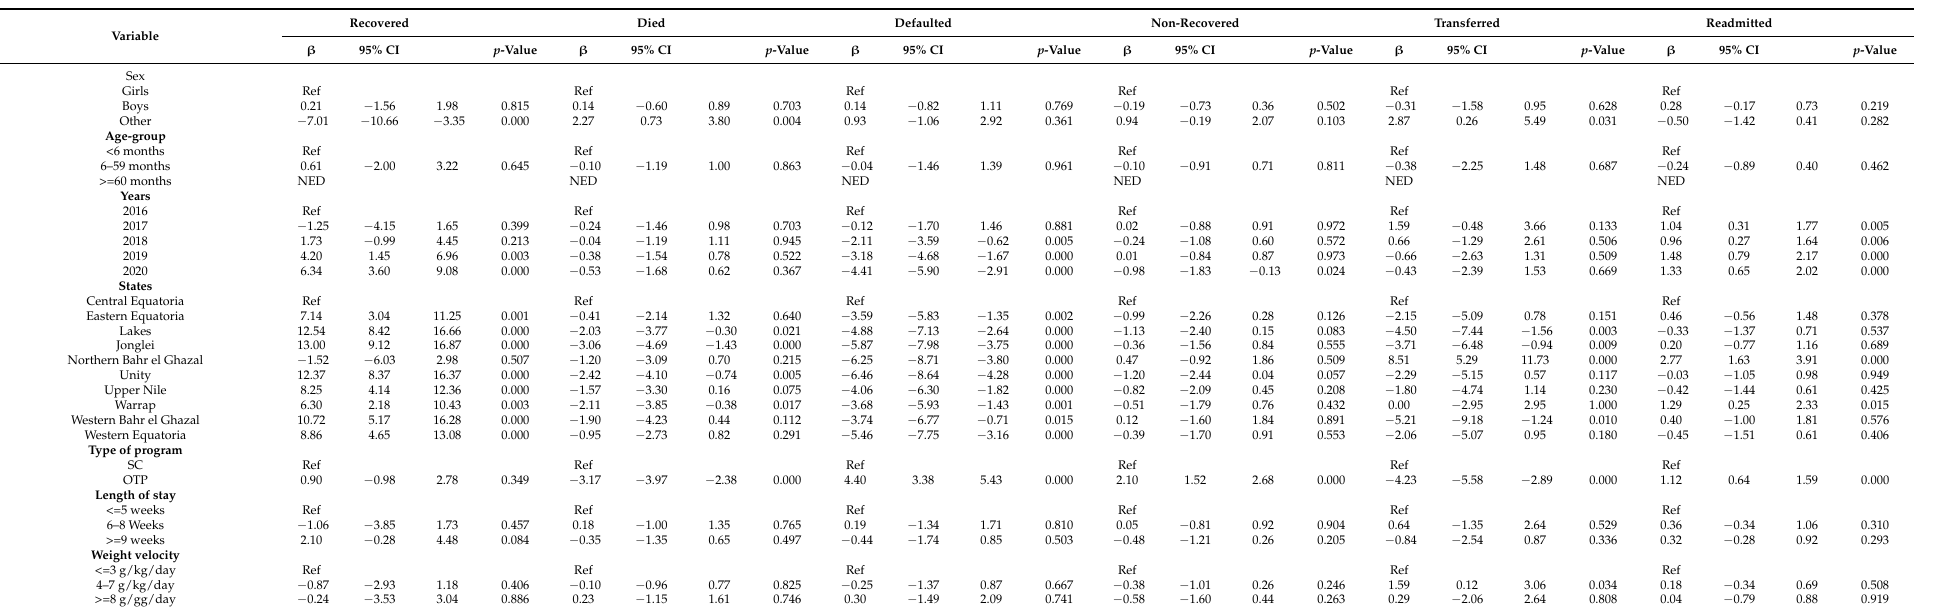
Table 5. Adjusted models exploring factors associated with exit outcome indicators and